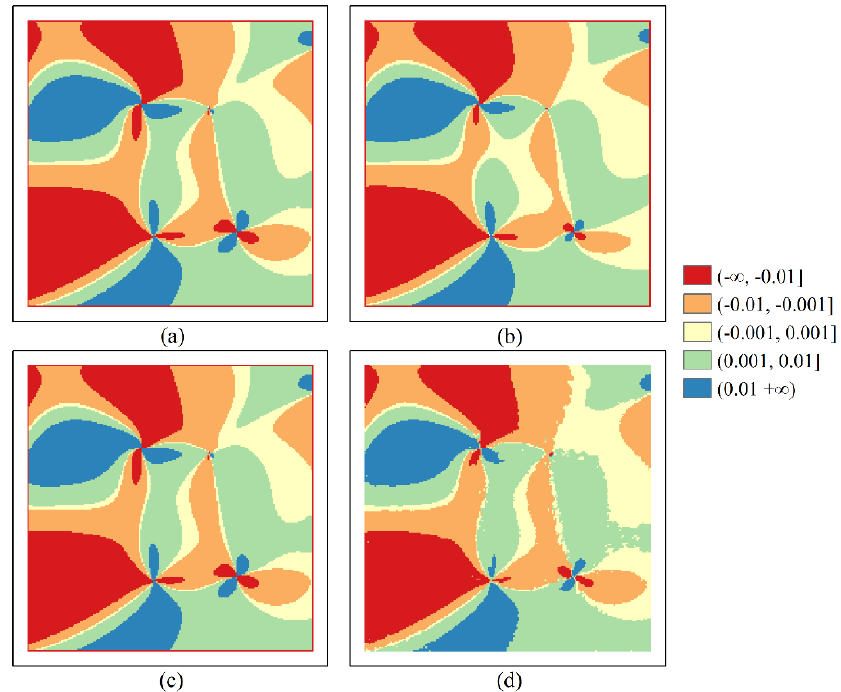
Figure 13. Spatial distribution of the residuals of the simulated C values relative to the theoretical C values on G4 for the: ( a ) Evans, ( b ) Zevenbergen, ( c ) Shary, and ( d ) FPN-based methods. Table 6. Number of residual values within different levels of four methods on E1, E2, E3, E4, G1, G2, G3, and G4. Algorithms Levels Evans Zevenbergen Shary